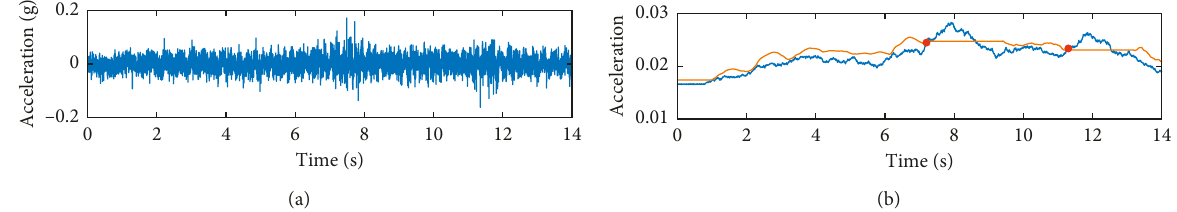
Figure 13: Vibration signal and 3 sigma outlier detection: (a) vibration signal; (b) outlier detection.